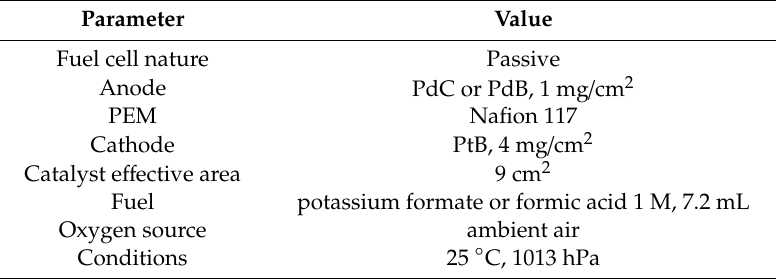
Table 1. Fuel cell parameters.